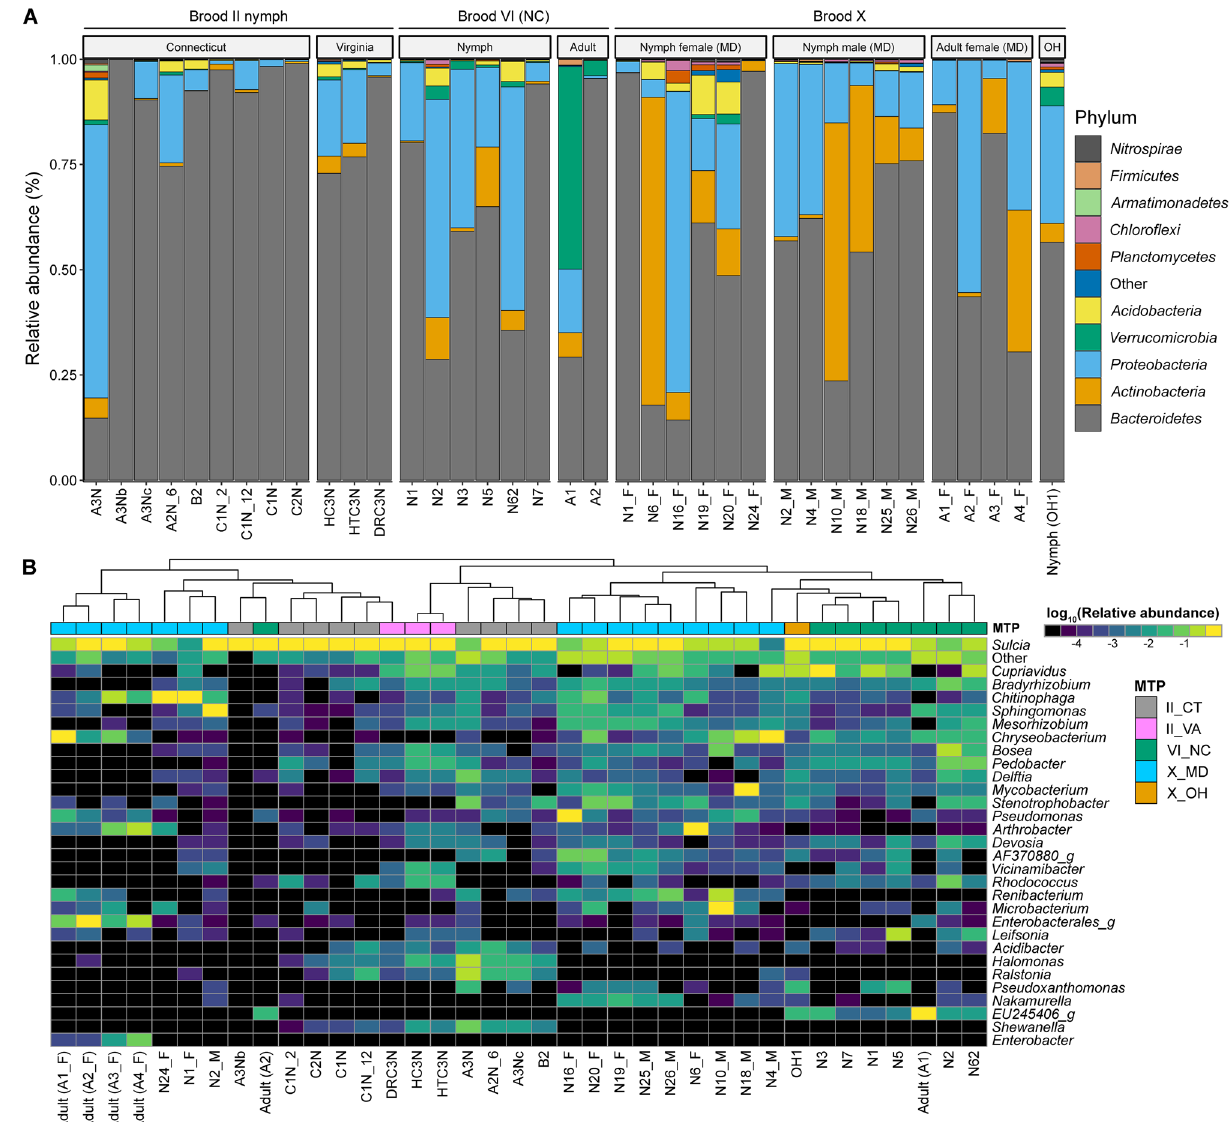
bacterial genera. Dendrogram shows k-means clustering of